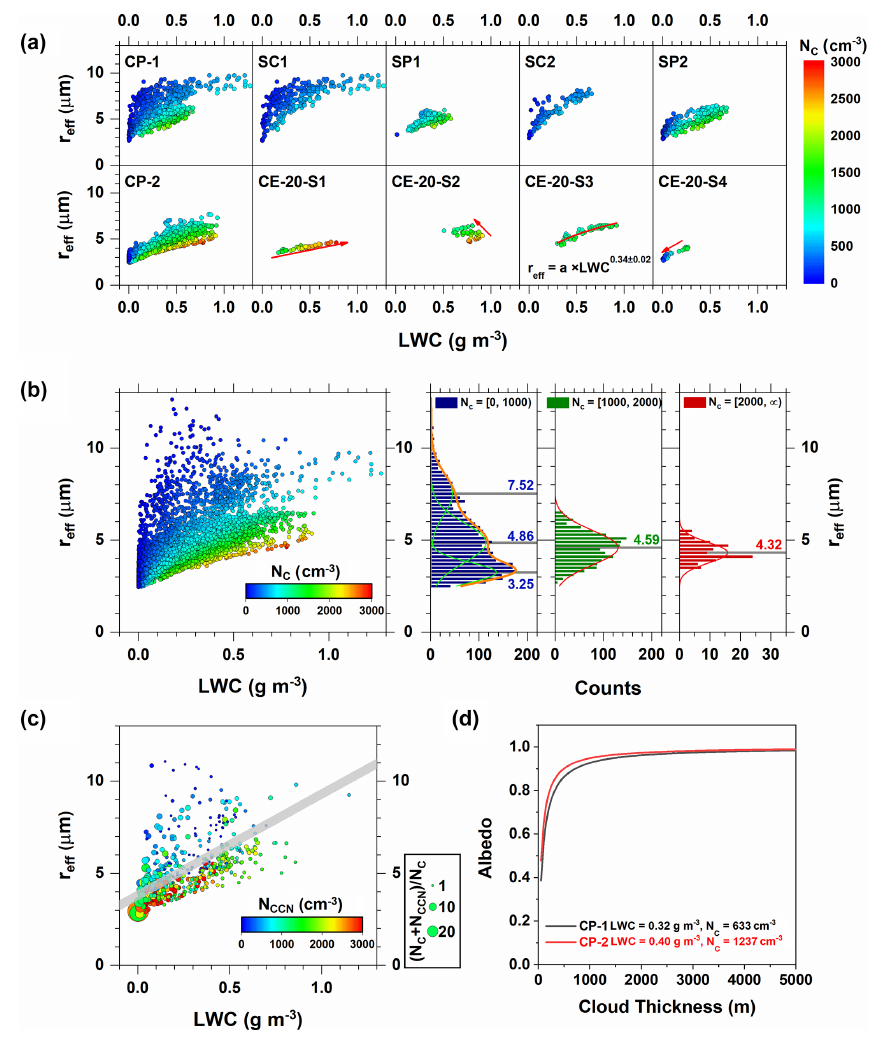
Figure 6. The plot of LWC versus r eff (a) in different cloud stages of CP-1 and CP-2, (b) under different N C ranges, and (c) under different N CCN . The time resolution of the corresponding data was 5min in (a) and (b) and 50min in (c) . (d) The plot of albedo versus the variation of cloud thickness during CP-1 and CP-2. The averaged values of LWC and N C of CP-1 and CP-2 were applied to calculate albedo according to the equations in Sect.